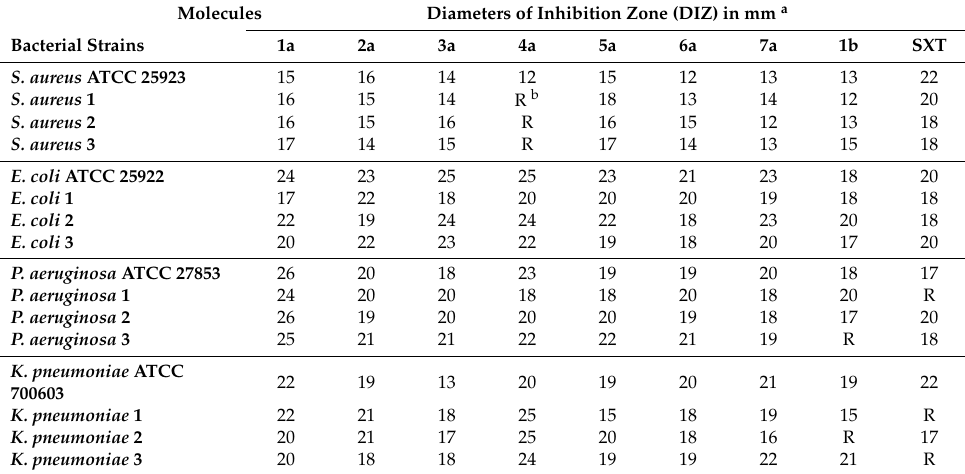
Table 4. Diameters of the inhibition zone (DIZ) of sulfamidocarbonyloxyphosphonate derivatives 1a – 7a , 1b , and SXT toward Gram-positive and Gram-negative